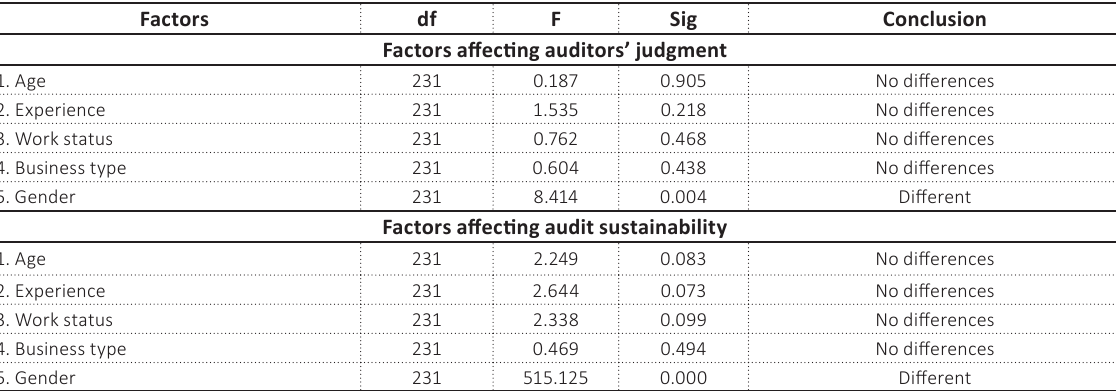
Table 6. Testing the differences according to the sample characteristics using ANOVA